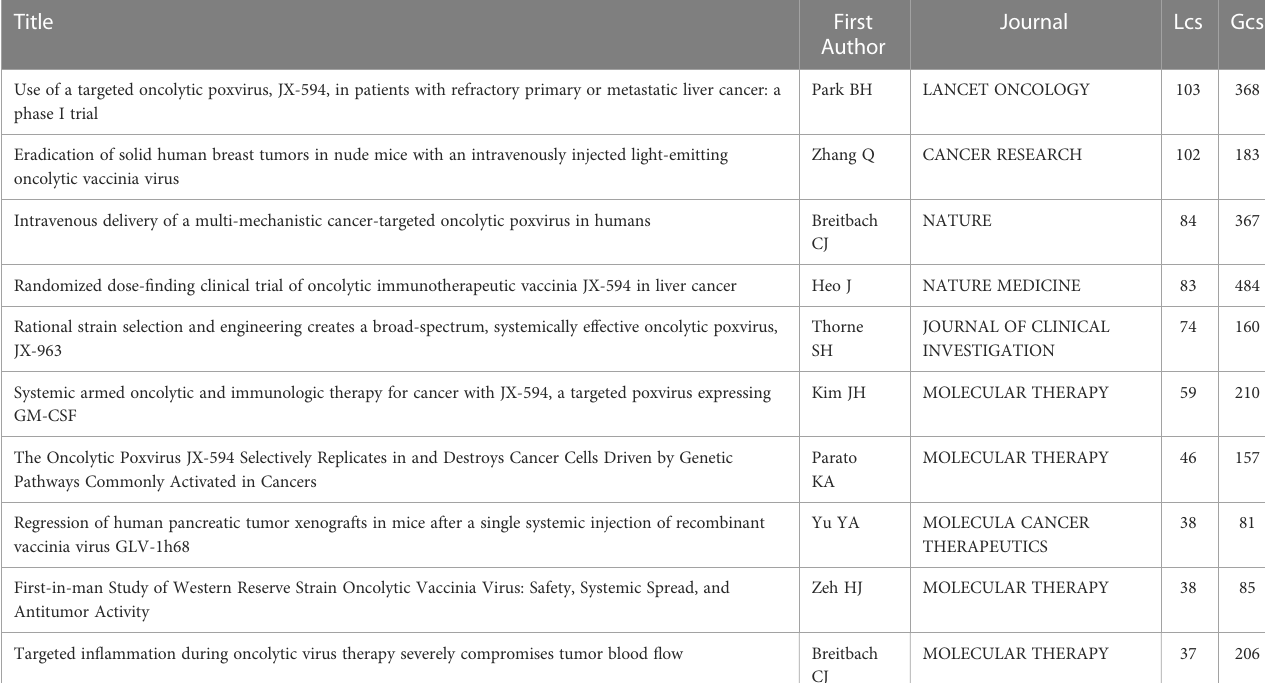
90% of the total number of publications in the fi eld. In terms of LCS, the United States has the highest citation rate, at 1,585, accounting for 79.8% of total citations. The second and third countries are Canada (624, 79.8%) and South Korea (597, 36.2%) (Figure 2B). In terms of H-index ranking, the United States (21), Canada (14) and Germany (13) are the top three, respectively (Figure 2C). All in all, the U.S. has maintained its dominance in this research area in terms of both quantity and quality of publications.